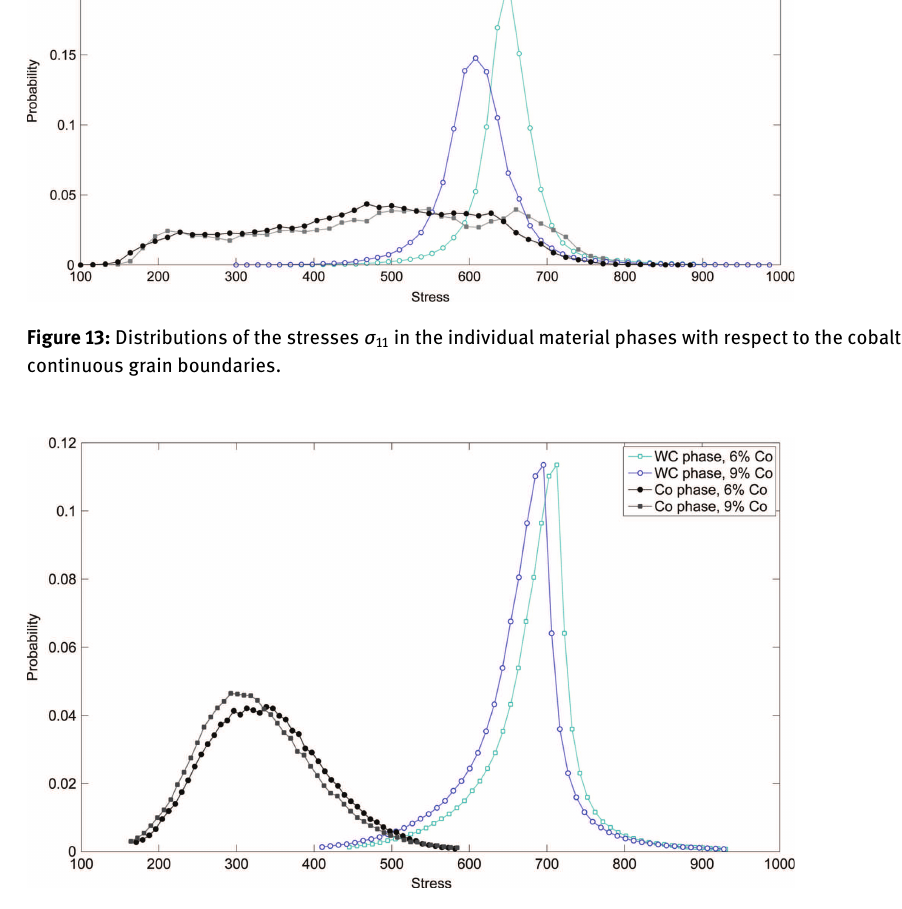
Figure 14: Distributions of the stresses σ 11 in the individual material phases with respect to the cobalt content, 3D model including cobalt